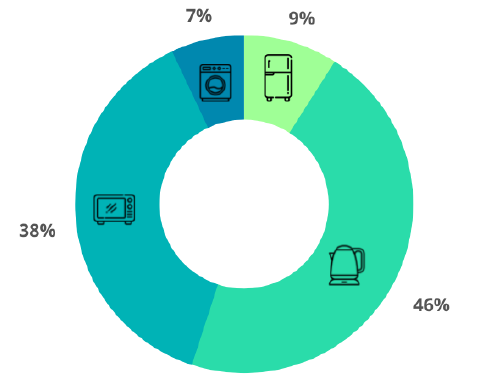
Figure 9. Energy consumption per appliance for resident awareness.